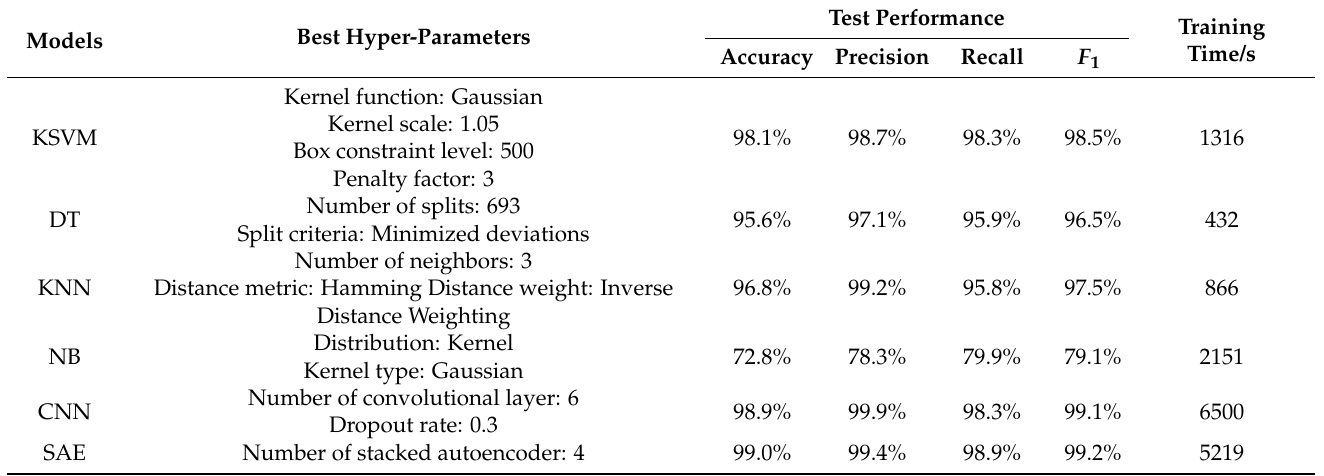
Table 5. Hyper-parameters and performance results of 6 classification models.